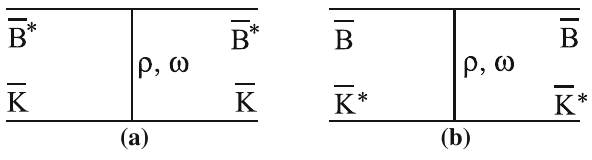
Fig. 3 Vector meson exchange for the ¯ B ∗ ¯ K and ¯ B ¯ K ∗ potentials